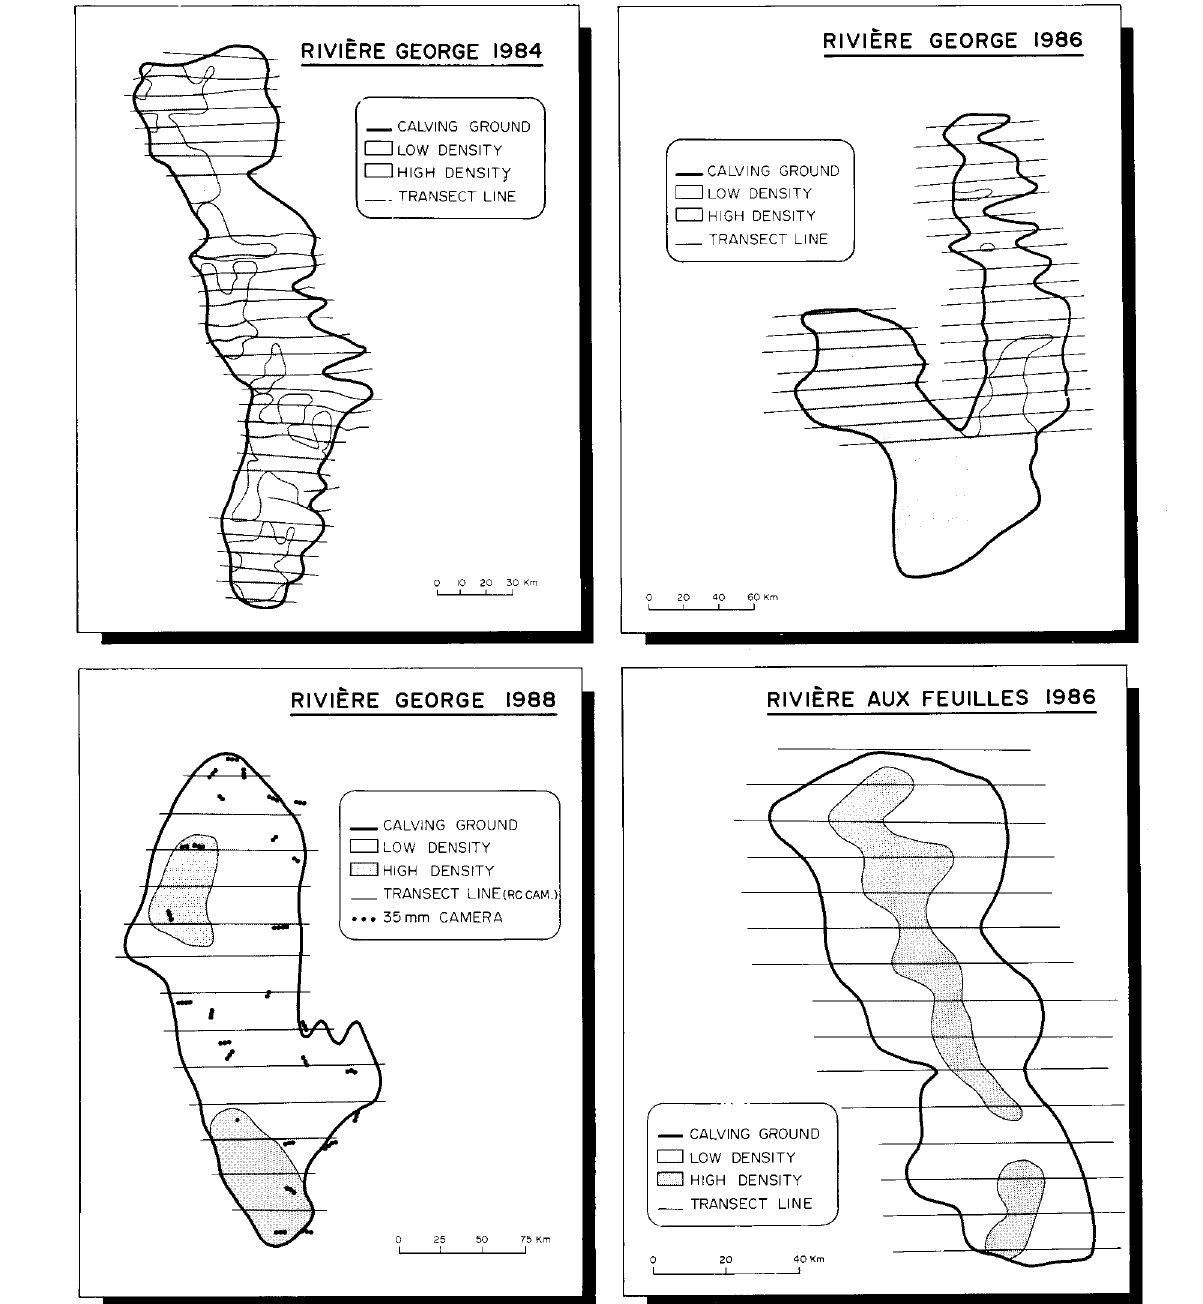
Figure 2. Transect lines along which RC-5 photos were les calving areas, and sampling plots used wi caribou density, northern Quebec. Selection of optimal plot and cluster size or 10 percent of the entire photo represented Although caribou densities varied between the the best sampling area. For practical reasons, a 4 subsamples of photographs, results were con rectangle covering 5 percent of the grid sistent (Table 1). In all cases, units covering 5